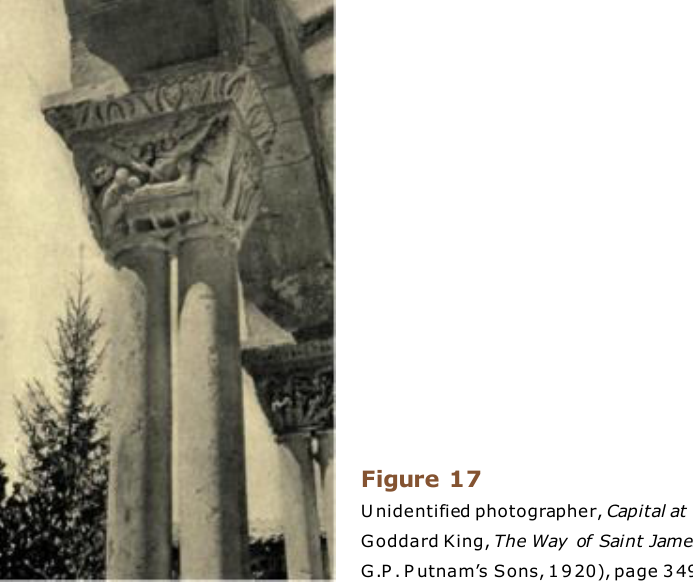
Unidentified photographer, Capital at Estella , from Georgiana Goddard King, The Way of Saint James , vol. 1 (New